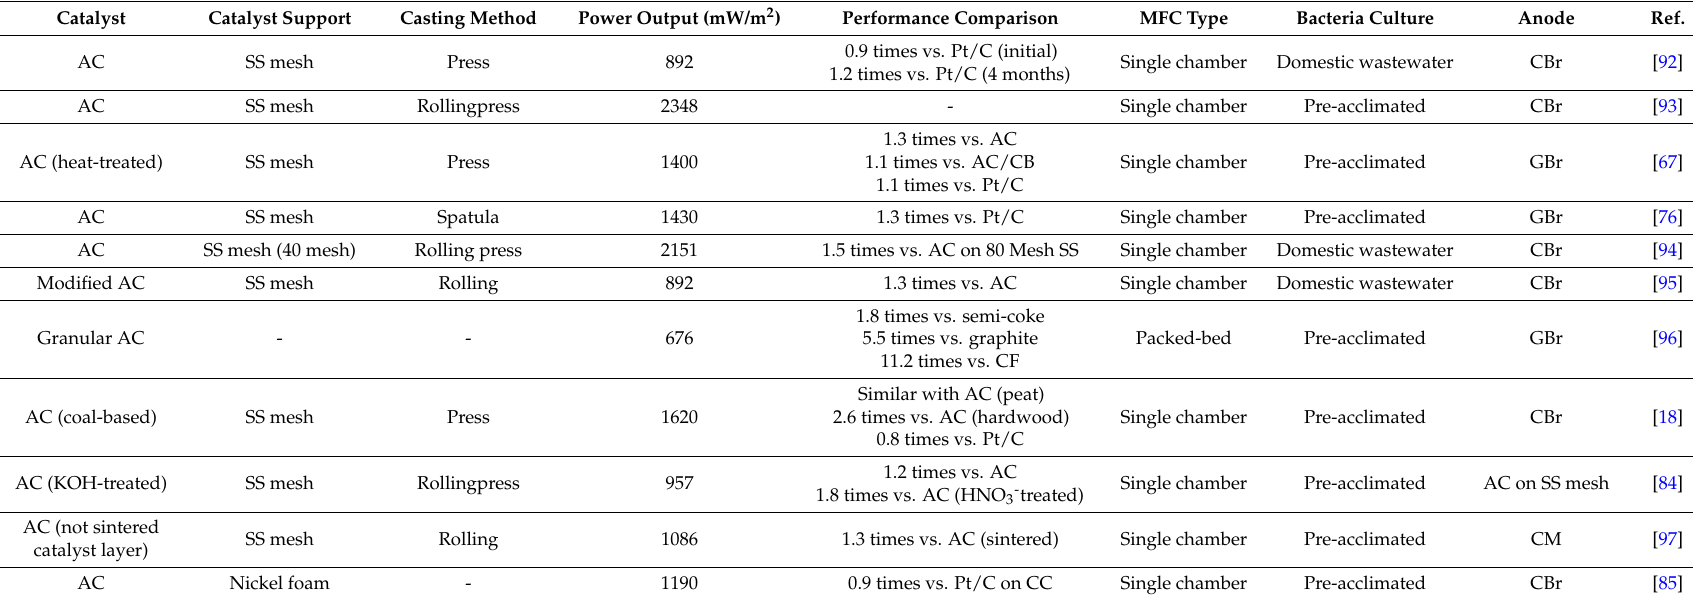
Table 2. Summary of the performance of different MFCs runs using AC as a